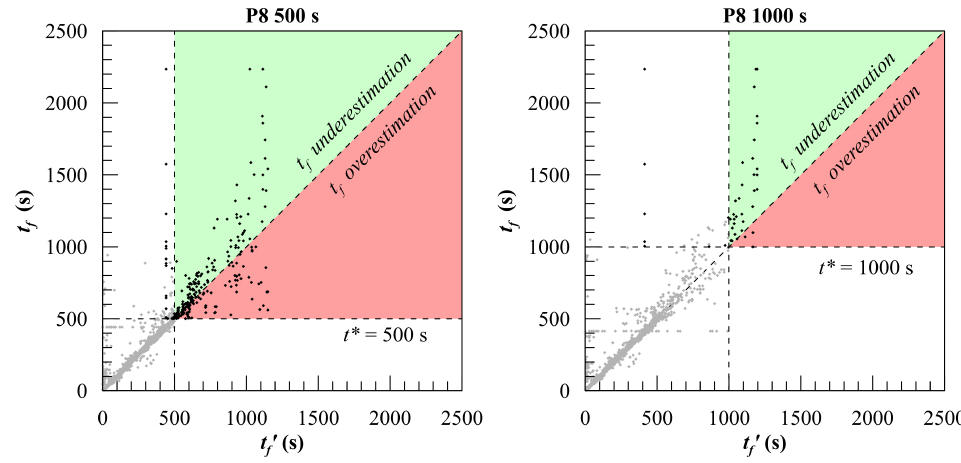
Figure 9. Predicted over observed values of t f computed at t ∗ = 500 s and t ∗ = 1000 s. Training: MC20; validation: MC50b; method: RFs.